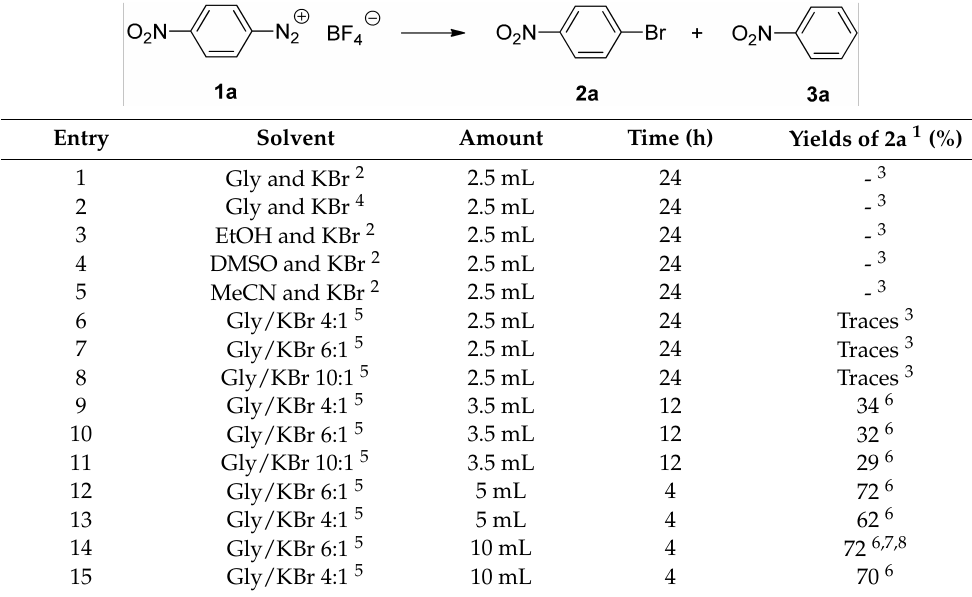
Table 2. Bromodediazotation: trial